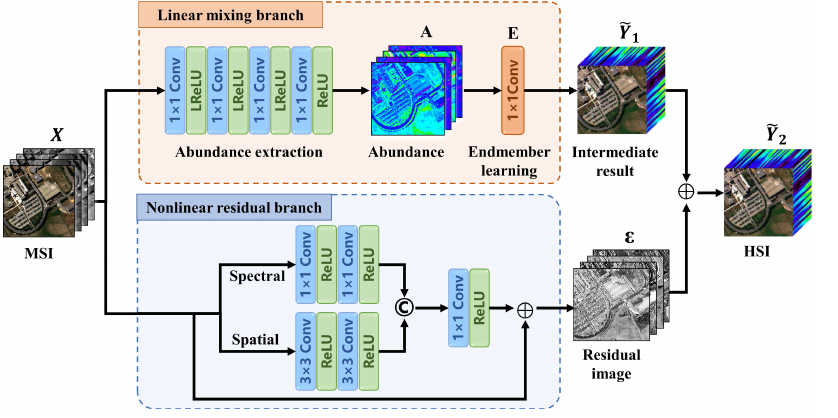
Figure 2. The architecture of a spectral mixing theory-based network. The proposed network consists of a linear mixing branch and a nonlinear residual branch. The linear mixing branch generates rough HSIs as an intermediate result through the abundance extraction module and endmember adaptive learning layer. The nonlinear residual branch extracts nonlinear features from the spatial and spectral dimensions of the multispectral images (MSIs), and maps them to a residual image. Finally, spectral super-resolution (SSR) is achieved by fusing intermediate results and residual